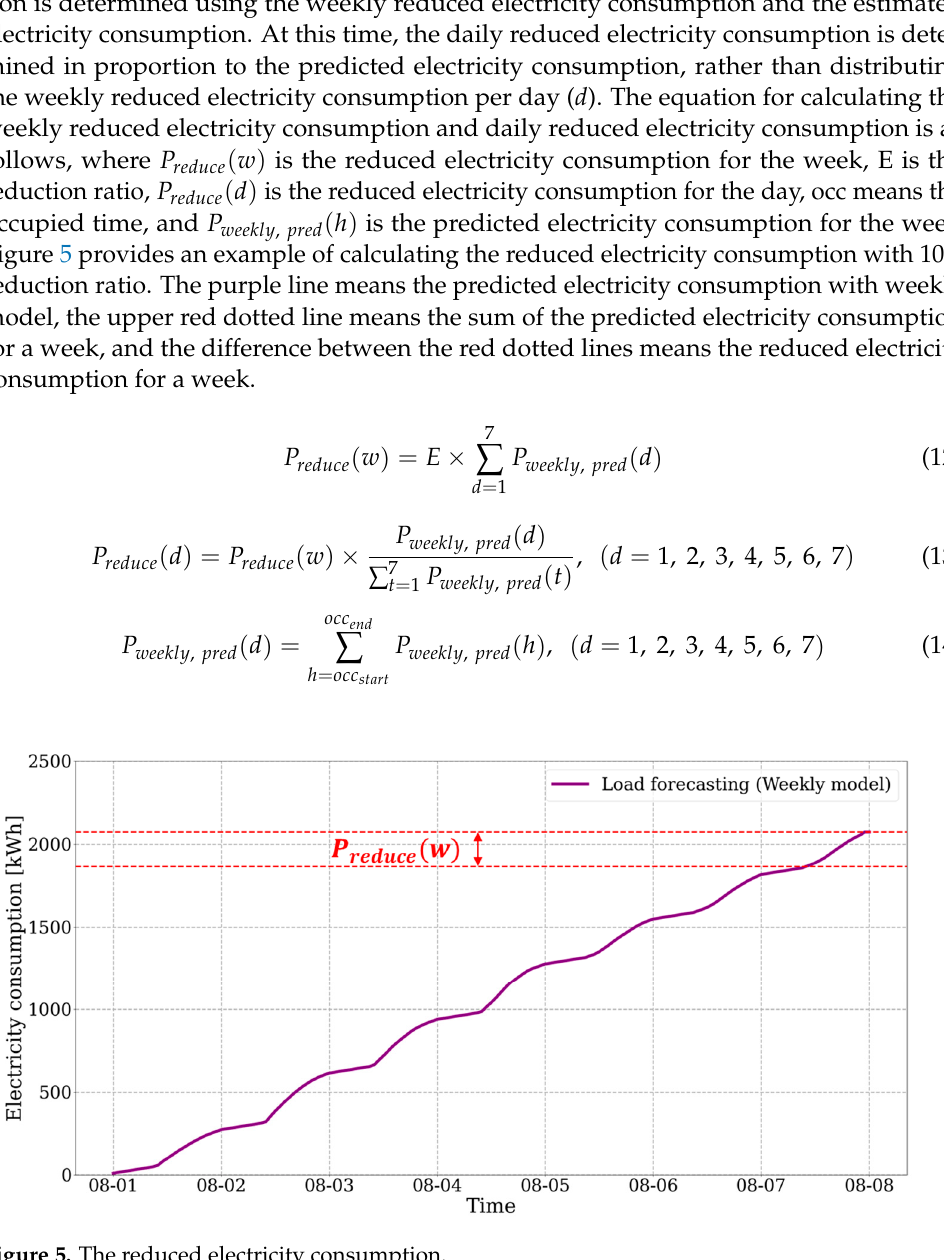
Figure 5. The reduced electricity